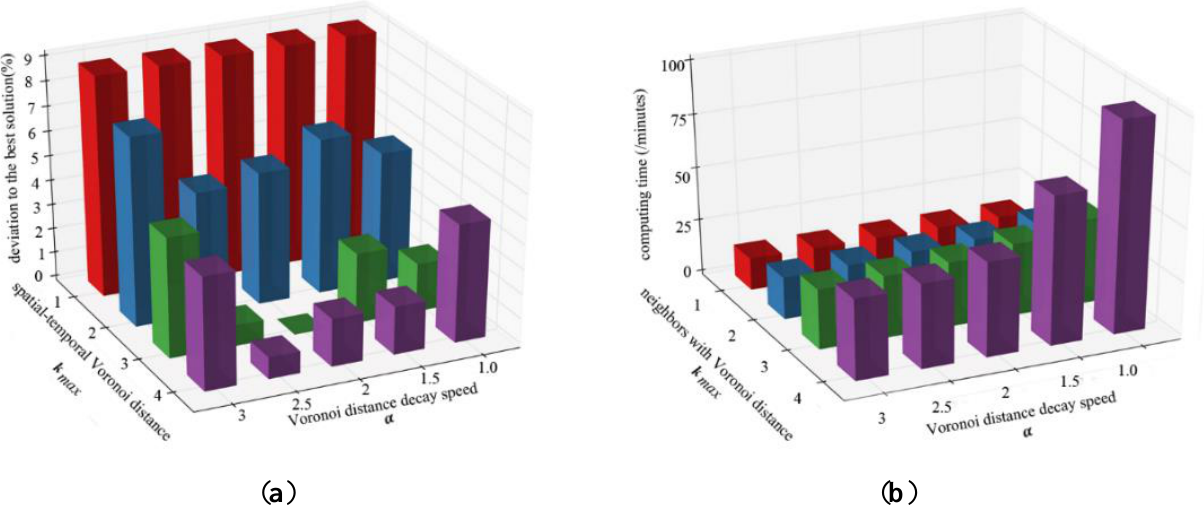
Figure 10. The impact of the spatial-temporal Voronoi diagram on the STVDH. ( a ) Deviation to the best solution; and ( b ) computing